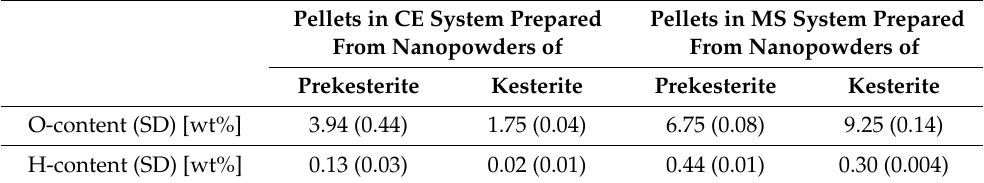
Table 4. The oxygen (O) and hydrogen (H) contents directly determined in the sintered pellets that were made from the prekesterite and kesterite nanopowders in the CE and MS precursor systems. Standard deviations (SD) of the determinations are shown in